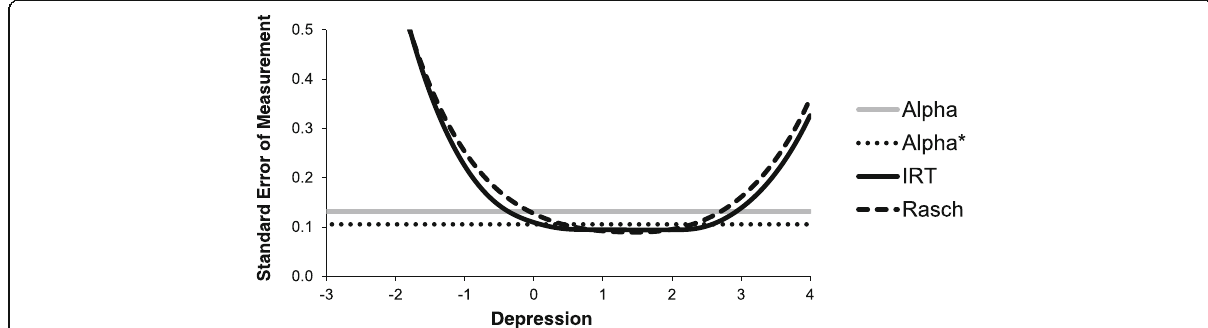
Fig. 5 Standard error of measurement for a 51-item depression scale according to Cronbach ’ s alpha (Alpha), Cronbach ’ s alpha based on